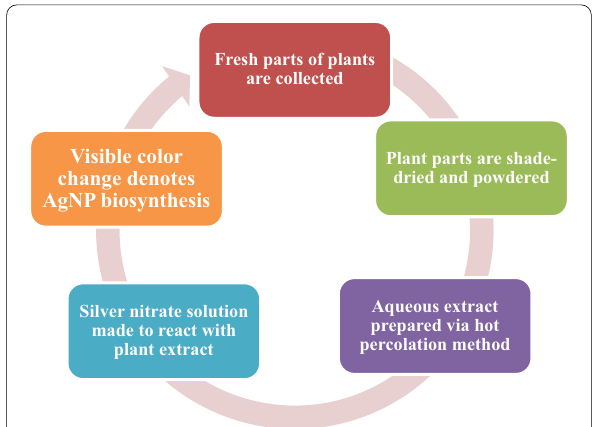
Fig. 2 Basic protocol for AgNPs synthesis via green